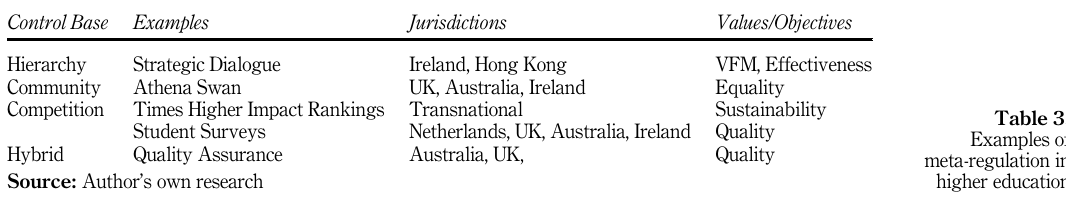
Table 3. Examples